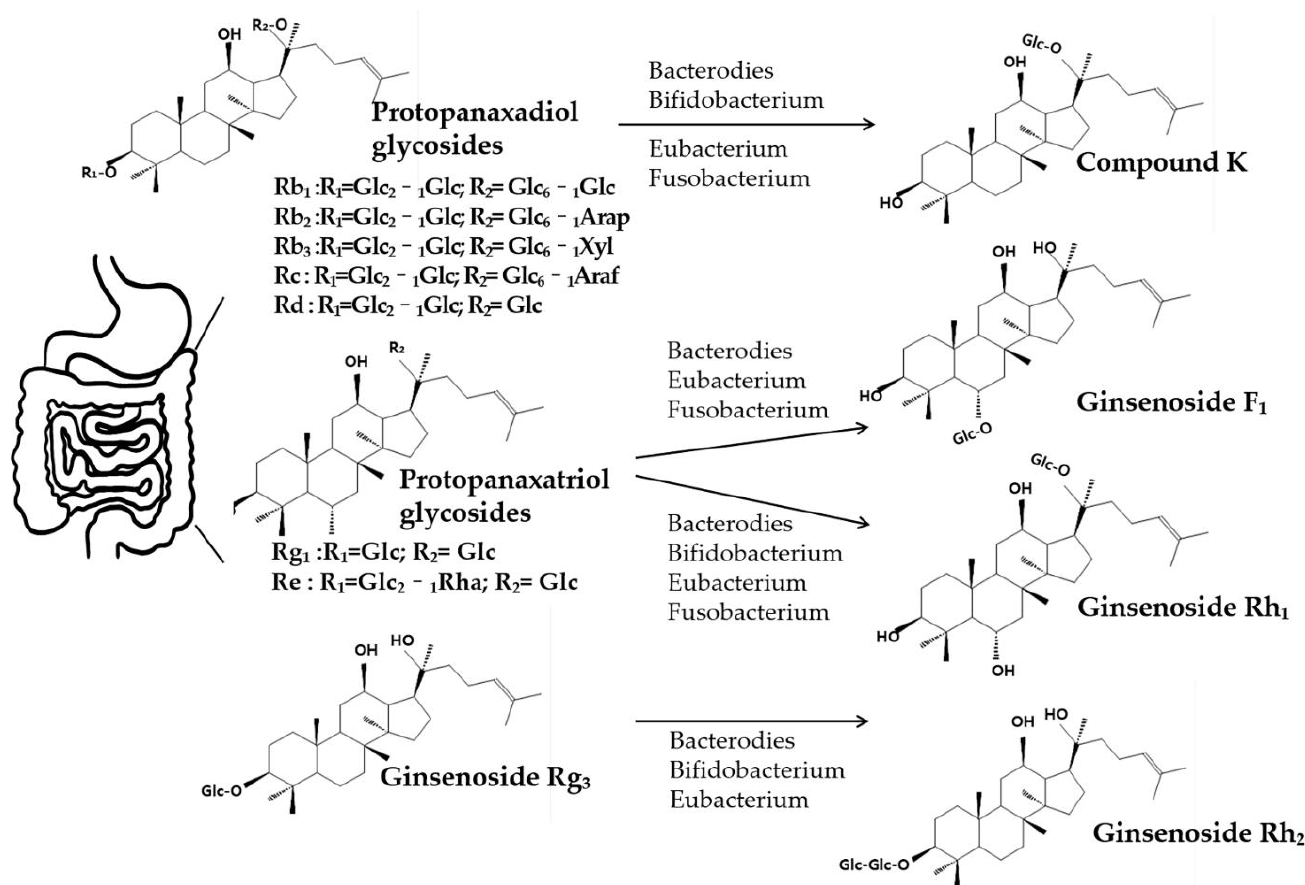
Figure 2. Schematic diagram of the pathway of PG and its metabolites. Ginsenosides are deglycosylated to compound K, ginsenoside F1, Rh1 and Rh2 by intestinal bacteria such as Bacteroides , Bifidobacterium , Eubacterium and Fusobacterium . Glc, β -D-glucopyranosyl; Arap, α -L-arabinopyranosyl; Xyl, β -D-xylopyranosyl; Araf, α -L-arabinofuranosyl.